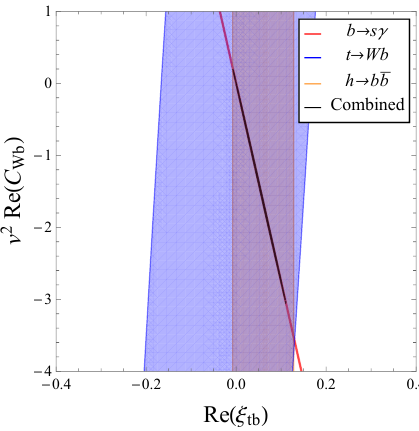
Figure 18 . The (cid:12)gure shows the constraints in the (cid:24) tb (cid:0) v 2 C Wb plane, illustrating the signi(cid:12)cant cancellations that can occur between the two couplings. The real (imaginary) couplings are shown in the left (right) panel. The exclusion bands (at 90% C.L.) assume that only C Wb and (cid:24) tb are generated at the scale